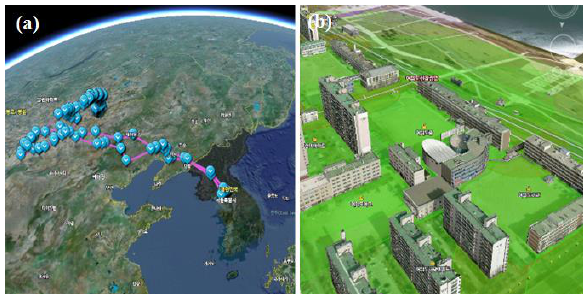
Figure 12. Mash-up Application Cases